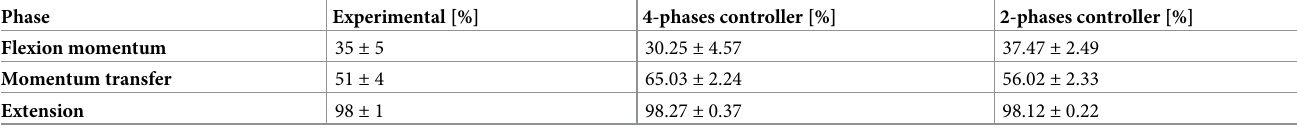
Table 6. Comparison of the three first phases between experimental, 4-phases and 2-phases model.